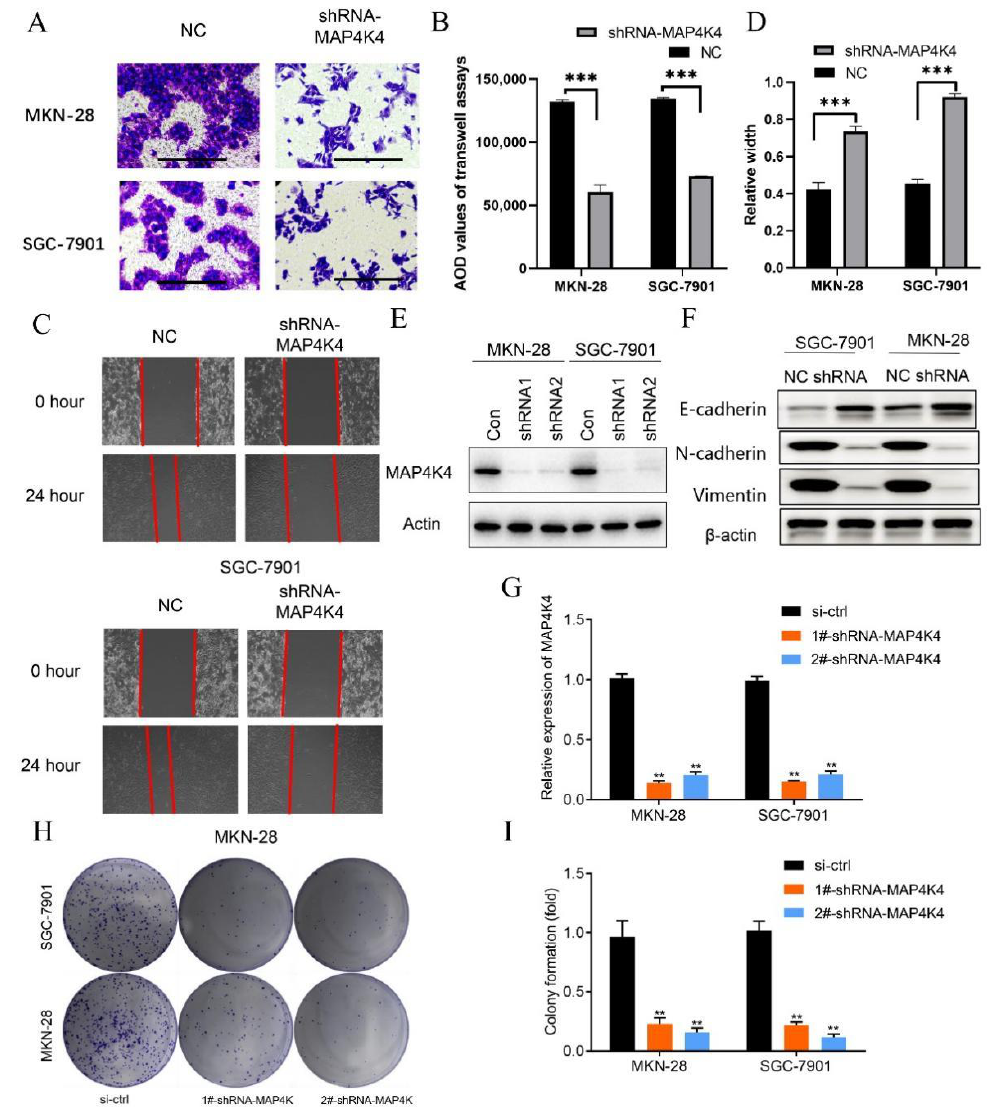
Figure 6. Detection of cell proliferation, invasion, and metastasis ability. ( A ) Transwell assay of normal condition (NC) and silenced MAP4K4 (shRNA-MAP4K4) in MKN-28 and SGC-7901 cell lines; ( B ) quantification from ( A ) the two-independent t-tests analyzes the difference of Transwell pictures’ AOD values; ( C ) wound-healing assay of normal condition (NC) and silenced MAP4K4 (shRNA-MAP4K4) in MKN-28 and SGC-7901 cell lines from 0 h to 24 h. (shRNA is delivered using a vector); ( D ) relative width of normal condition (NC) and silenced MAP4K4 (shRNA-MAP4K4) in MKN-28 and SGC-7901 cell lines in 24 h compared to 0 h. The two-independent t-tests analyze the difference in relative widths; ( E ) expression of MAP4K4/Actin determined by Western blot (WB) in MKN-28 and SGC-7901 cell lines before silencing MAP4K4 and after silencing MAP4K4 actin; ( F ) expressions of E-cadherin (Cat: AF748), N-cadherin (Cat: 13-2100), Vimentin (PRO-309), and control β -actin proteins determined by WB analysis in MKN-28 and SGC-7901 cell lines before silencing MAP4K4 (NC) and after silencing MAP4K4 (shRNA); ( G ) relative expression of MAP4K4 with si-ctl or silenced MAP4K4 (shRNA-MAP4K4) in MKN-28 and SGC-7901 cell lines; ( H ) clone formation assay of MKN-28 and SGC-7901 cells with si-ctl or silenced MAP4K4 (shRNA-MAP4K4); ( I ) clone formation statistics of MKN-28 and SGC-7901 cells with si-ctl or silenced MAP4K4 (shRNA- MAP4K4). Data of the three independent experiments are represented as mean ± SD. The significance is determined by two-way ANOVA. ** p < 0.01, *** p < 0.001. Correlational analyses are used to obtain the significant differences (Figure